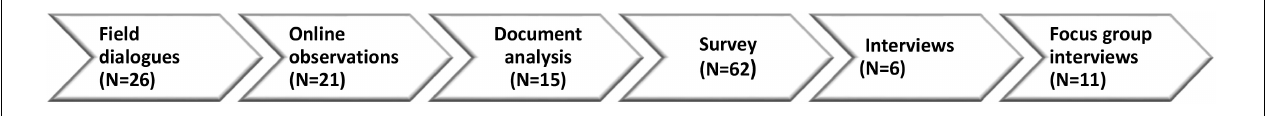
FIGURE 2 | The cumulative research